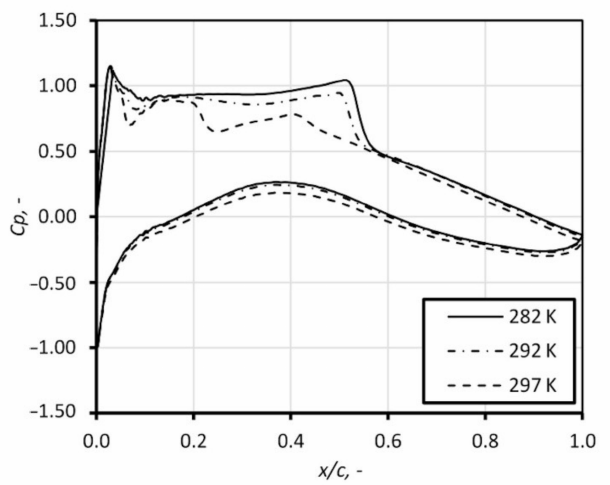
Figure 12. Influence of the inlet total temperature on pressure coe ffi cient distribution on the airfoil for humid air with relative humidity of 50%.